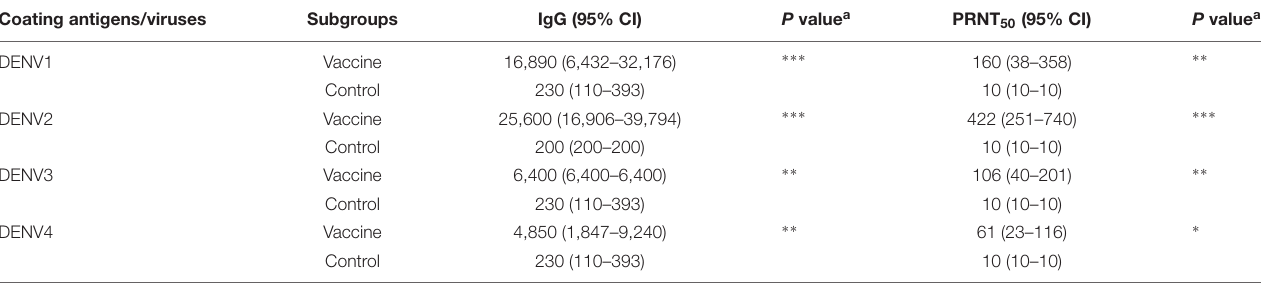
FIGURE 4 | Protective efficacy against DENV2 challenge in different immunization regimens. Mice immunized with different regimens were challenged i.c. with DENV2 and monitored daily for body weight and survival rate for 12 consecutive days ( n = 8). (A–C) Percentage changes of body weight from day 0 were determined as 100 × (weight post-challenge)/(weight pre-challenge). Data were expressed as mean ± SD, (D–F) The survival rate shown as the percentage of survivors. ∗ P < 0.05, ∗∗ P < 0.01, ∗∗∗ P < 0.001. TABLE 1 | GMTs of DENV-specific IgG and PRNT 50 in sera of DDP group. Coating